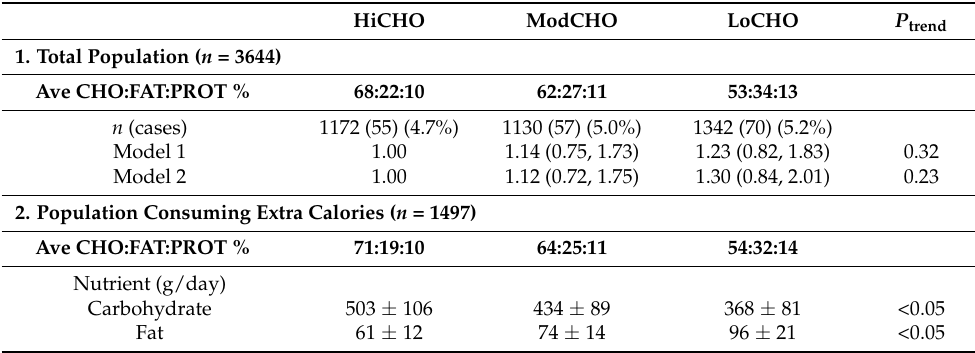
Table 3. Relative risk (95% Confidence interval) of type 2 diabetes across tertiles of low-carbohydrate, high-fat and high-protein diet scores in the Harbin People’s Health Study (Cohort 1, 2008–2012). HiCHO ModCHO LoCHO P